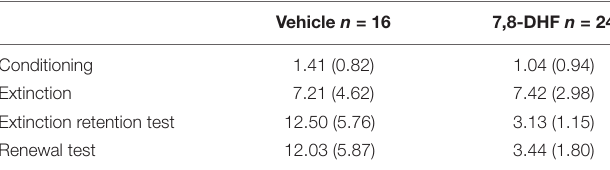
TABLE 2 | Mean (SEM) pre-CS freezing across sessions for data included in Analysis